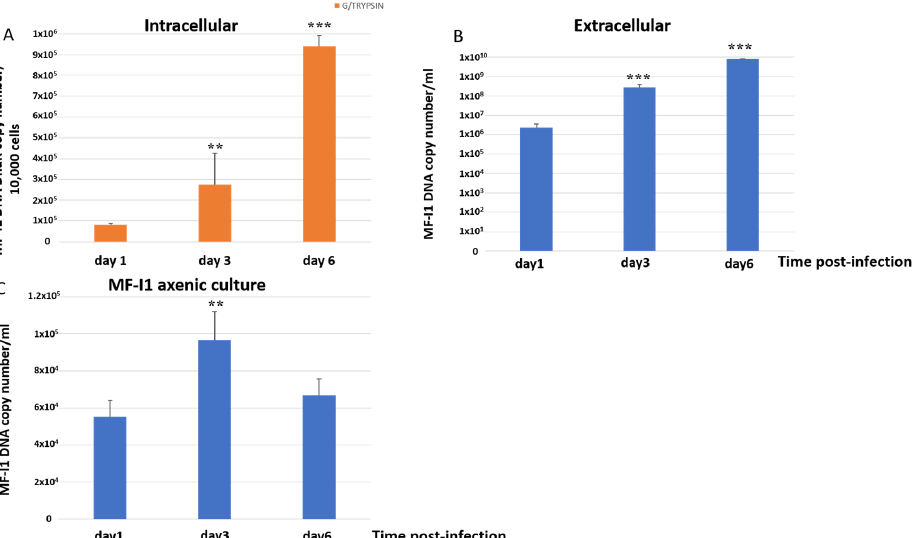
Figure 1. Quantification of dnaK DNA copy number. DNA copy number per 10,000 cells infected trypsinized from MF-I1 infected HCT116 cells ( A ) and DNA copy number per ml of supernatant from HCT116 infected cells ( B ) was collected and analyzed at day 1, 3, and 6 after infection. ( C ) DNA from parallel cultures of MF-I1 isolate grown in McCoy’s 5A medium, cell-free, axenic medium was collected and analyzed after 1, 3, and 6 days of culture post-inoculum. MF-I1 DNA copy number was ascertained by Q-PCR using primers specific for the dnaK gene. MF-I1 DNA levels in the infected cells were normalized to albumin DNA. Data represent the mean values ± S.E. of samples run in triplicate and are representative of data from three different experiments. The p -values were calculated by two sample t -test. ** = p -value between 0.05 and 0.01; *** = p -value <